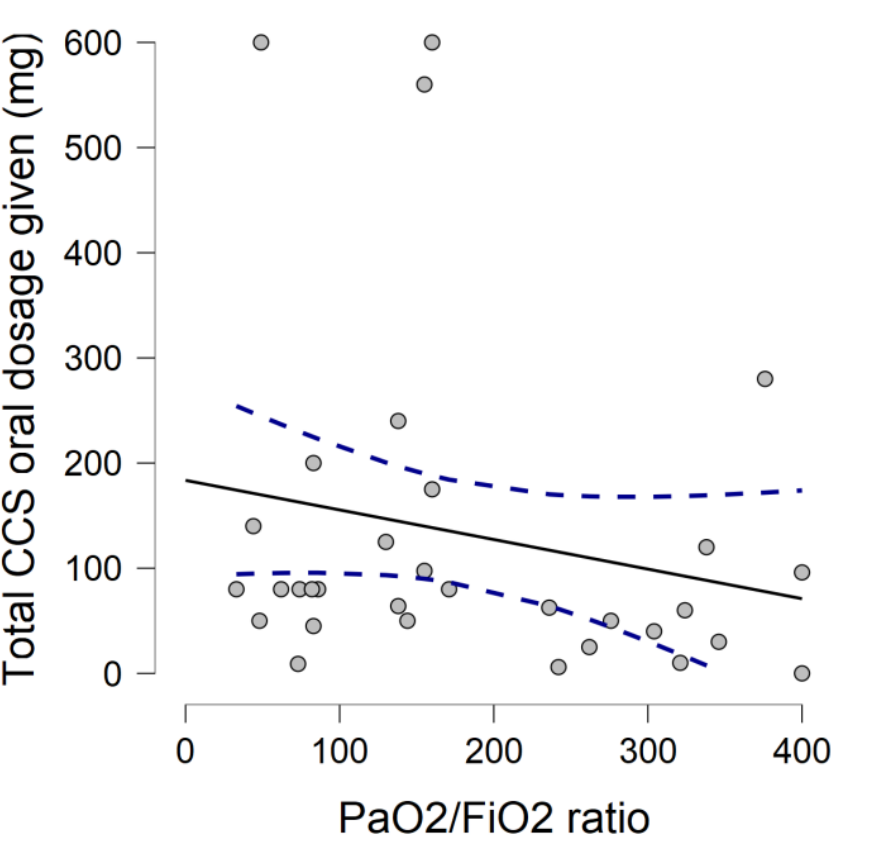
Figure 2. Correlation plot between PaO 2 /FiO 2 ratio at nadir and total corticosteroid dosage received prior to hospital admission.